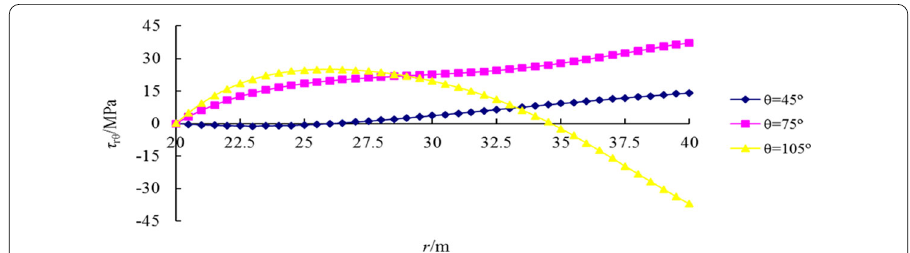
Figure 8 Distribution of shear stress for three different